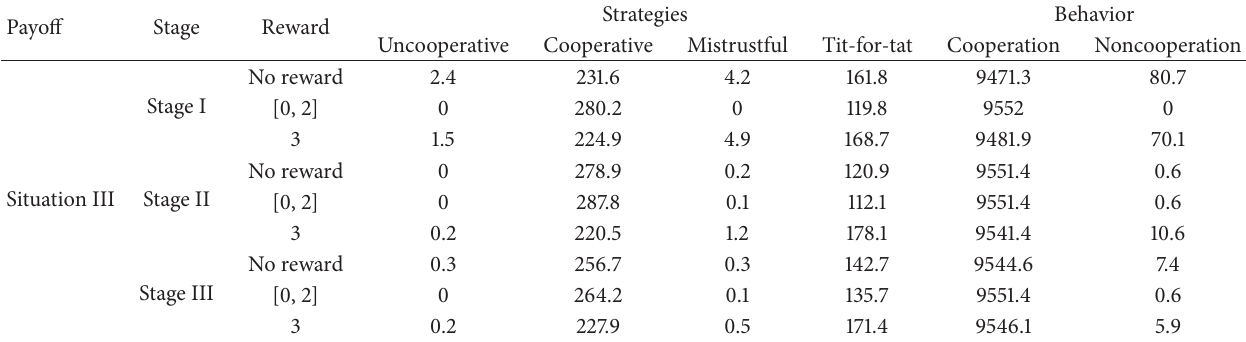
Table 6: Average frequencies of different strategy in Situation III of innovation with each incentive. Payoff Stage Reward